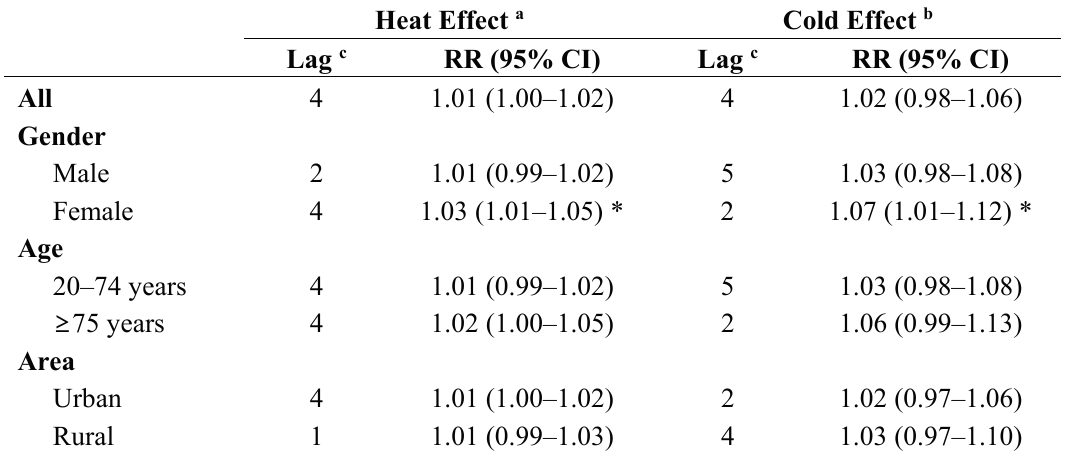
Table 4. The relative risk(RR) of heat and cold effects on AMI hospital admissons in warm weather period by gender, age, and